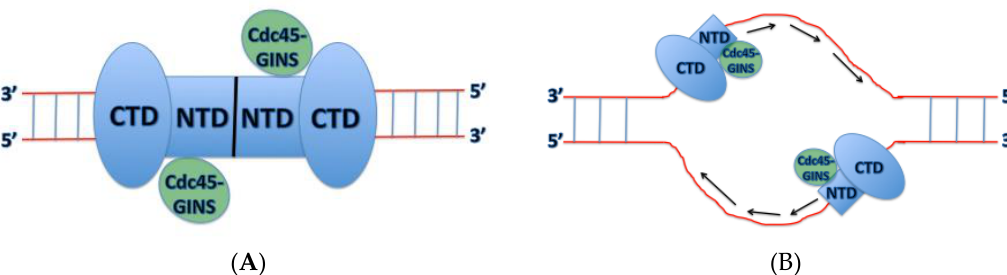
Figure 5. The newly proposed DNA polarity and direction of CMG translocation. ( A ) the two active CMG complexes bound by the Mcm2-7 N-terminal domains on dsDNA prior to origin melting; ( B ) the two active CMG complexes translocate in a 3′ → 5′ direction with the N -terminal domain in front of the C-terminal domain. The two CMG complexes must encircle ssDNA before they can pass each other and unwind further duplex DNA.